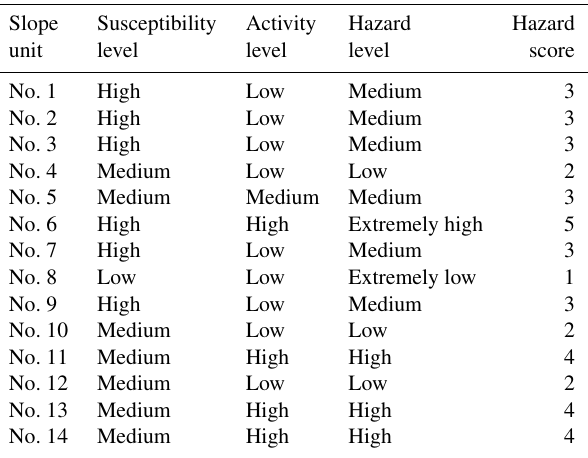
Table 15. Hazard levels and scores of slope units around the Neikui- hui